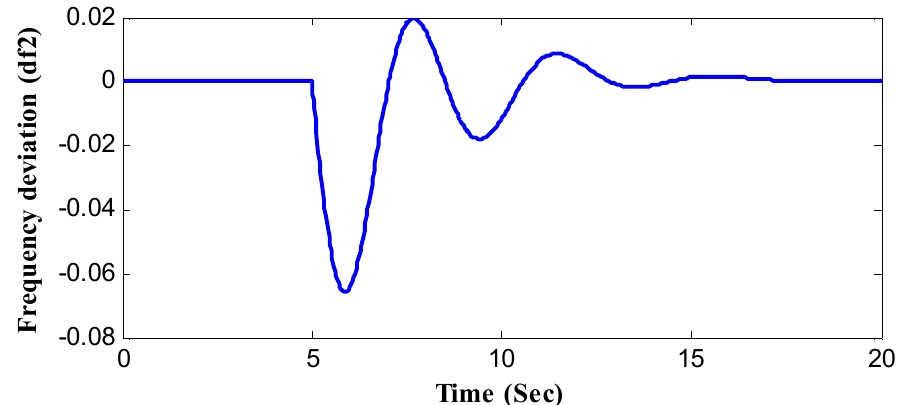
Figure 6. Frequency deviation ( ∆𝑓 (cid:2869) ) using conventional 2DOF-OPID controller